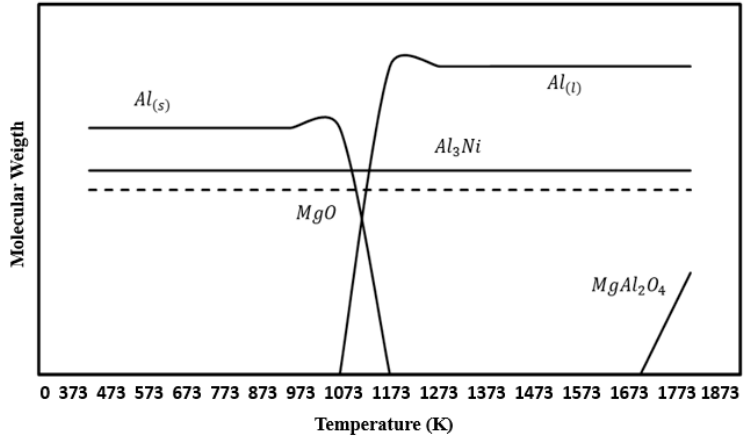
Figure 11. Equilibrium diagram of species for the Al-Mg-NiO system in the temperature range from 373 to 1873 K.